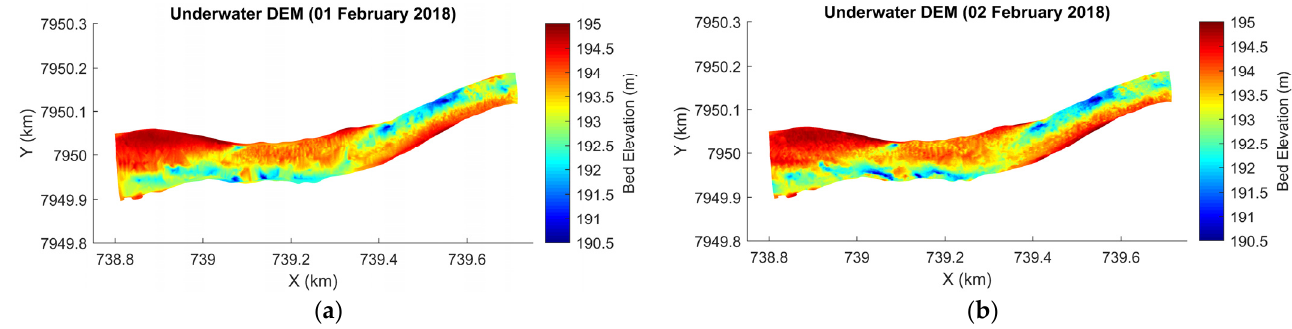
Figure 4. Underwater DEMs generated for ( a ) 1 February 2018 and ( b ) 2 February 2018.